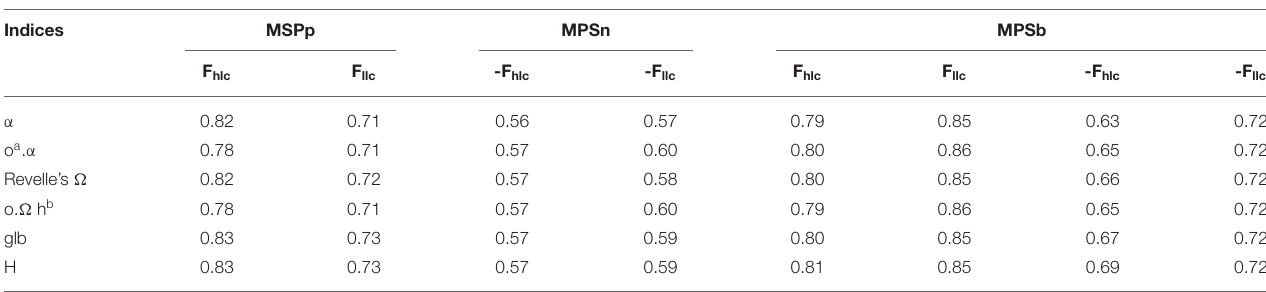
TABLE 4 | Reliabilities of the three scale